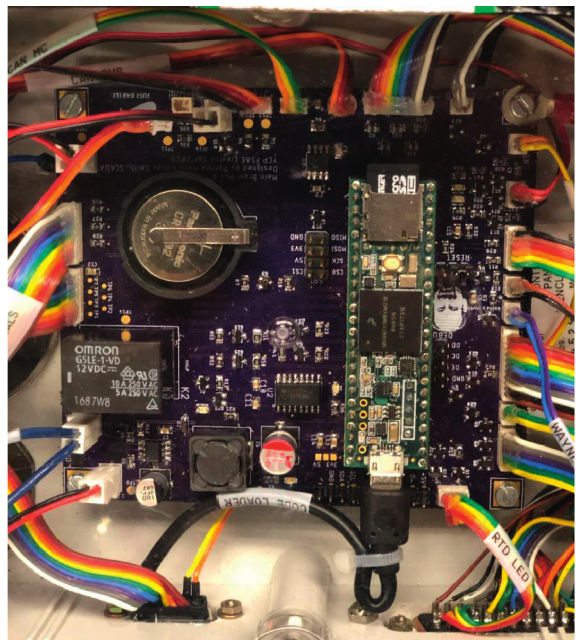
Figure 9: SCADA main